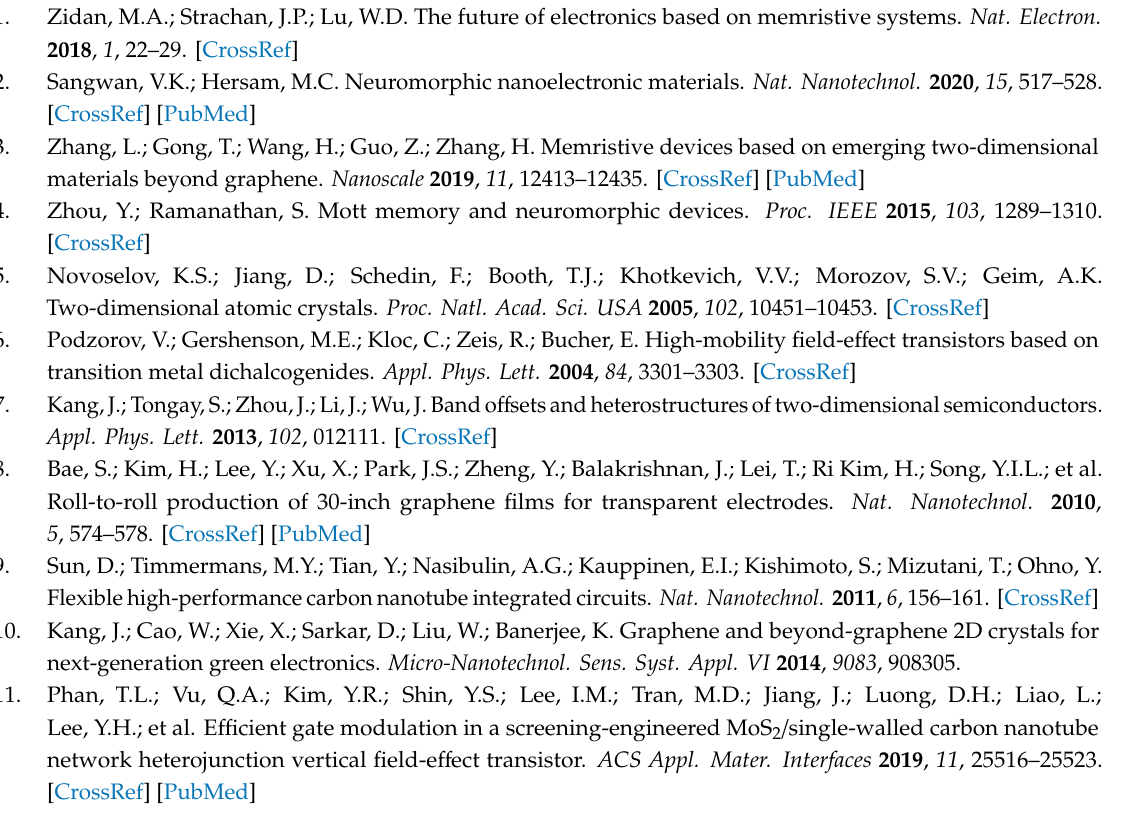
Figure S1: The CVD growth condition for NbSe2 flakes; Figure S2: Raman mapping image according to E2g mode at 250 cm − 1 of the CVD-grown NbSe2; Figure S3: CVD NbSe2 growth tendency according to the optimization of carrier gas ratio (N2:H2); Figure S4: Electrical characteristics of various other CVD-grown NbSe2 flakes; Figure S5: The oxidization e ff ect of the thin CVD-grown NbSe2 flake; Figure S6: Formation of channels in a memristor device structured with NbOx / NbSe2 heterostructure; Figure S7: Retention properties of the NbOx / NbSe2 memristor under 0.01-V read voltage; Figure S8: I–V curves of NbOx / NbSe2 memory devices, displayed on a double-logarithmic scale; Figure S9: I–V characteristic of NbOx / NbSe2 heterostructure memristor along with the influence of oxidation time (0–24 days); Figure S10: Electrical comparison of memristor under vacuum and ambient condition. Supplementary Note 1: Explanation of the conduction mechanism of our NbOx / NbSe2 memory device based on the SCLC mechanism; Supplementary Note 2: Explanation of the relationship between the exposure time and device